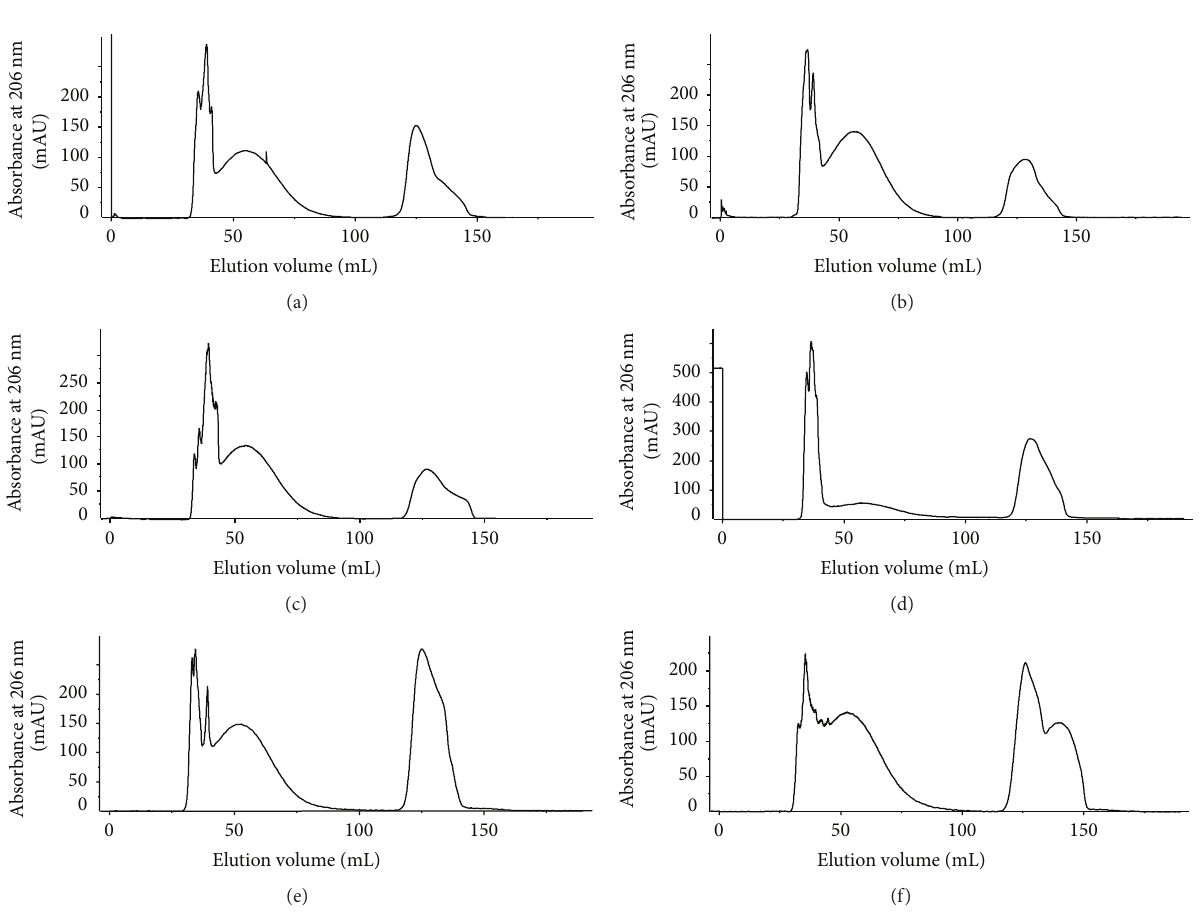
Figure 3: Elution profile of six batches of Ingovax ACWY vaccine. Chromatograms of batches (a) 15001, (b) 15002, (c) 15003, (d) 15004, (e) 15005, and (f) 15006 are shown. The peak absorbance was monitored at 206nm.